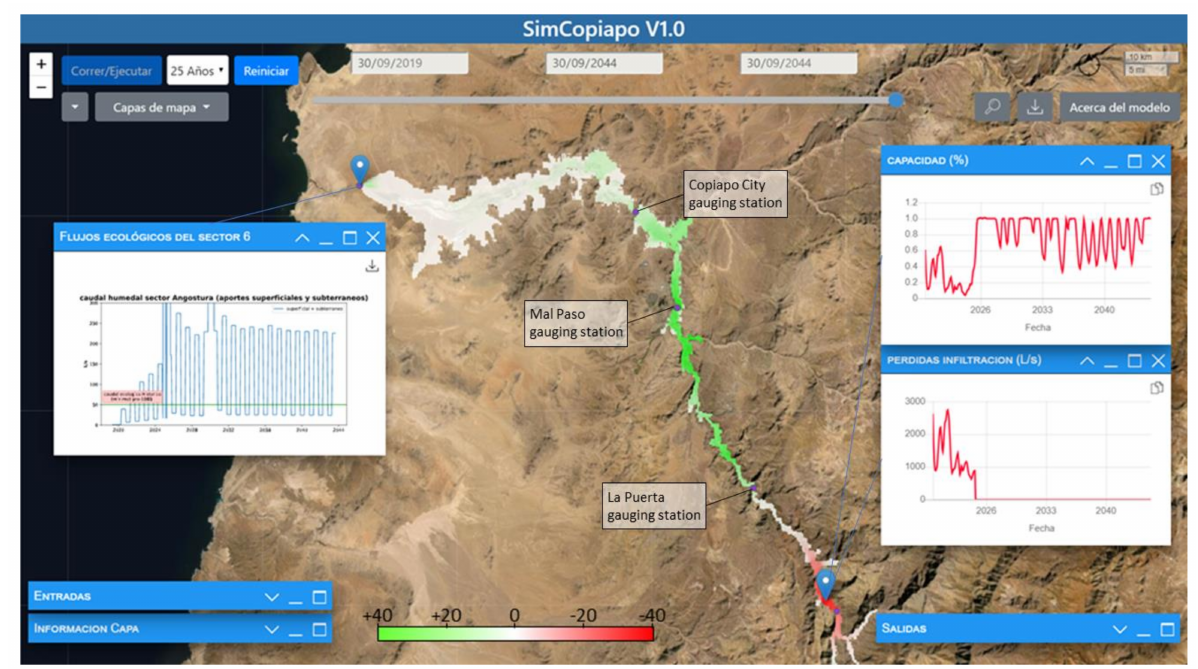
Figure 13. Groundwater head difference (m) between base scenario and combined water strategies. Inside panels show results of Lautaro Reservoir water balance (storage (% maximum volume) and infiltration losses (L/s)) and river flows (L/s) at the outlet of the